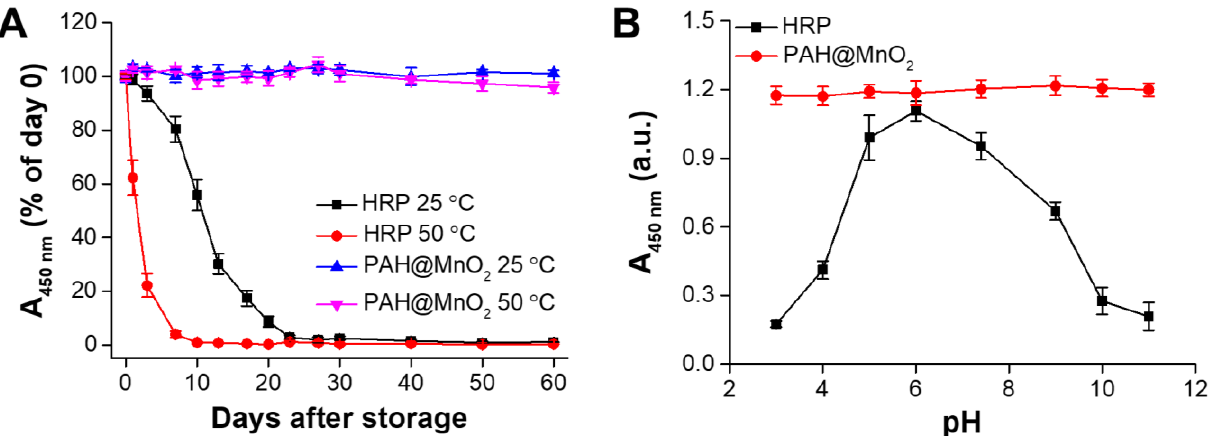
Figure 3. ( A ) The stabilities of HRP and PAH@MnO 2 after storage at 25 and 50 °C for periods of 1 – 60 days. PAH@MnO 2 showed no decrease in oxidisability towards H 2 O 2 /TMB after 60 days of storage at 50 °C. The values are means ± SD ( n = 3); ( B ) the absorbances at 450 nm of HRP and PAH@MnO 2 in the presence H 2 O 2 /TMB in PBS with various pH levels. The values are means ± SD ( n = 3).